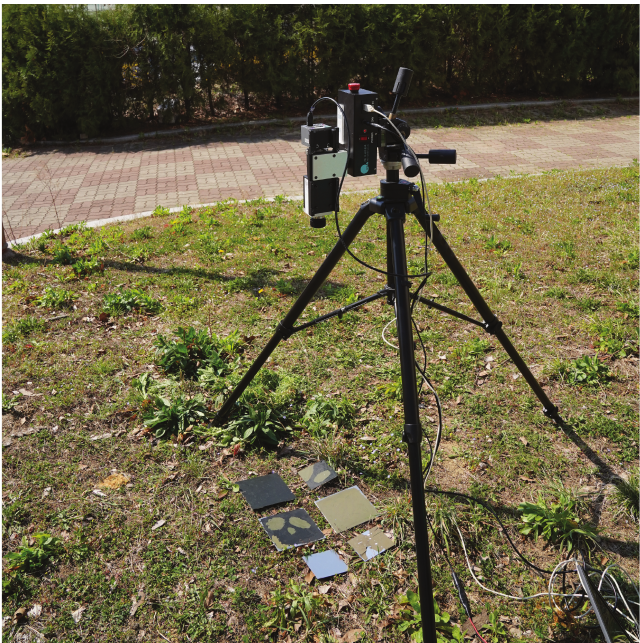
Figure 10. Acquisition of the YU paint